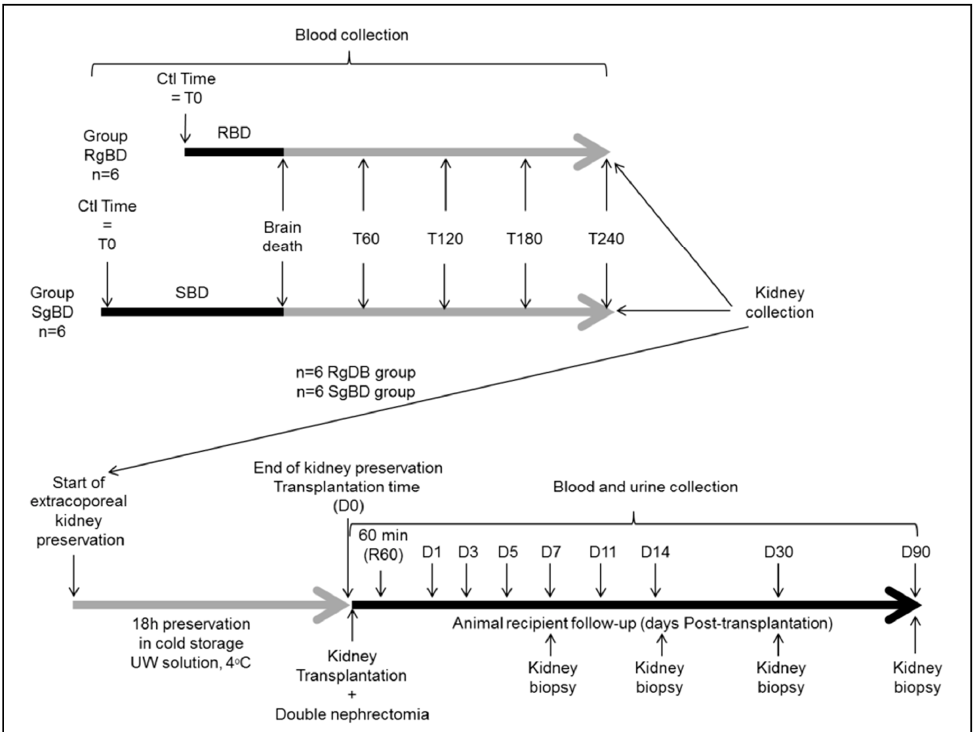
Figure 6. Experimental design.